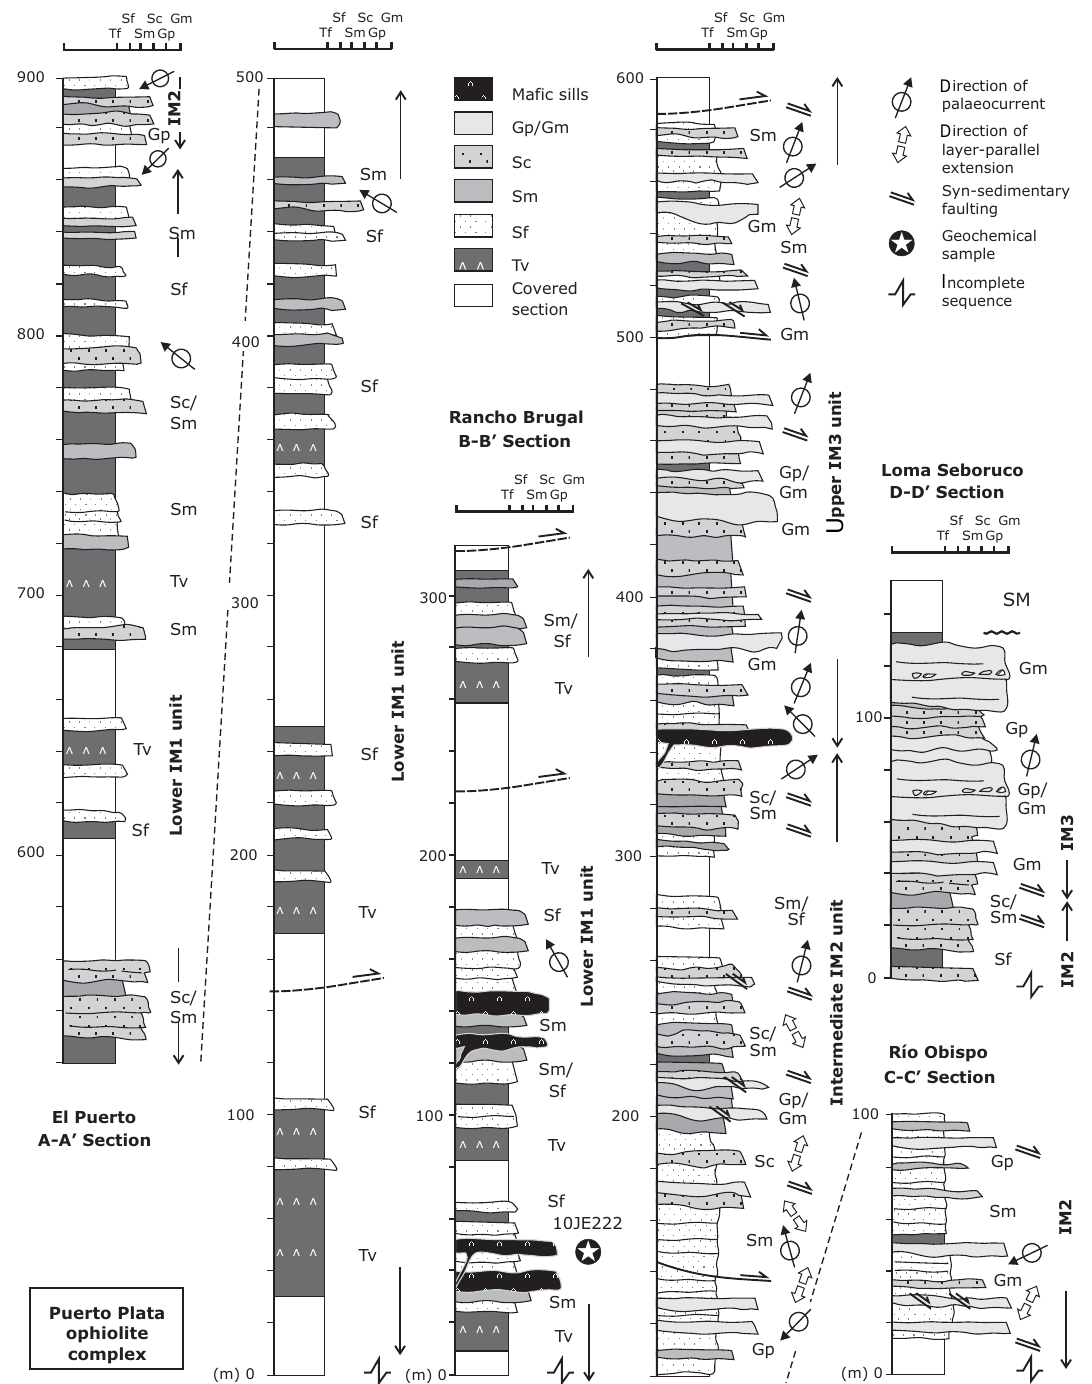
Figure 3. Stratigraphic sections of the Imbert Fm as exposed in the Puerto Plata ophiolitic complex. See text and Supplementary Material A for details and Fig. 2 for location. Sedimentary facies assemblages: Gp, clast-supported, sandy (polymictic) breccia and conglomerate; Gm, massive breccia and matrix-supported, muddy-sandy (polymictic) conglomerate; Sc, medium-to-thick bedded coarse-grained sandstone and microconglomerates; Sm, thin-bedded, medium-to-fine-grained sandstone; Sf, fine-grained sandstone, siltstone and laminated mudstone; Tv, fine-grained tuff with alternating fine-grained tuffaceous sandstone and